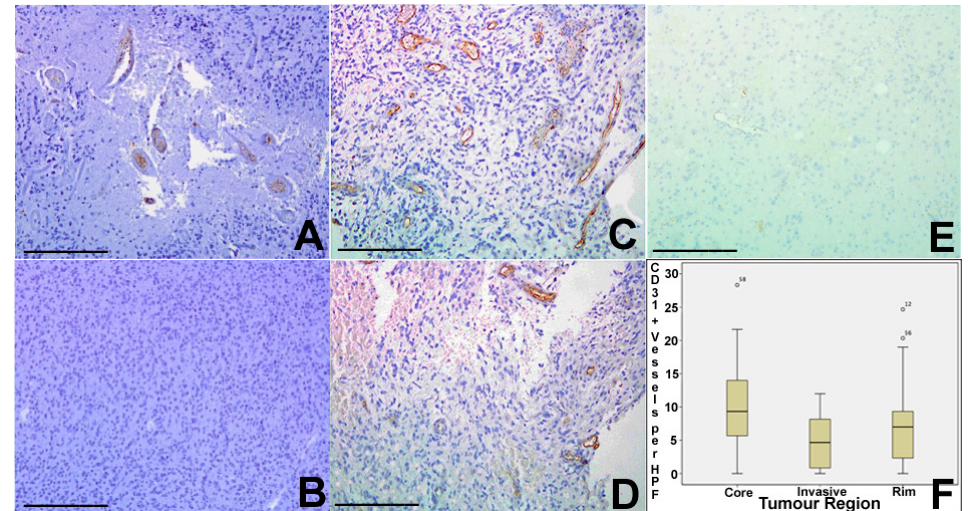
Figure 3. The GBM invasive margin is characterised by a distinct vasculature. Tumour vascularity was assessed using CD31 (PECAM-1) immunohistochemistry, identifying the number of vascular structures per HPF. ( A , B ) Core tumour regions showed a median of 9 vessels pre HPF (range 0–28), ( C , D ) rim regions a median of 7 vessels per HPF (range 0–25) and ( E ) invasive areas a median of 5 (range 0–12). There was statistically significant variation between areas ( p = 0.025 Kruskal Wallis) with significant differences between core and invasive and between core and rim regions on pairwise t -test. ( F ) Relative levels of CD31 positivity between core, rim and invasive tumour areas. On post-hoc T-test, there was statistically significant variation between areas. ( A – E ) ×40. Error bars ( A – E ) 100 µm.